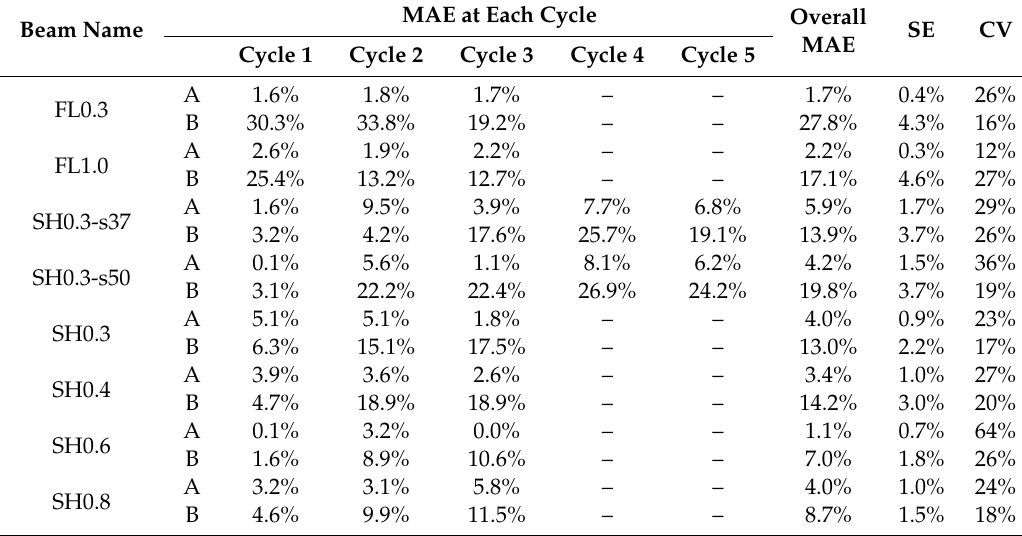
Table 5. Error calculation in the prediction of load, P (slender beams), or deformation, δ (deep